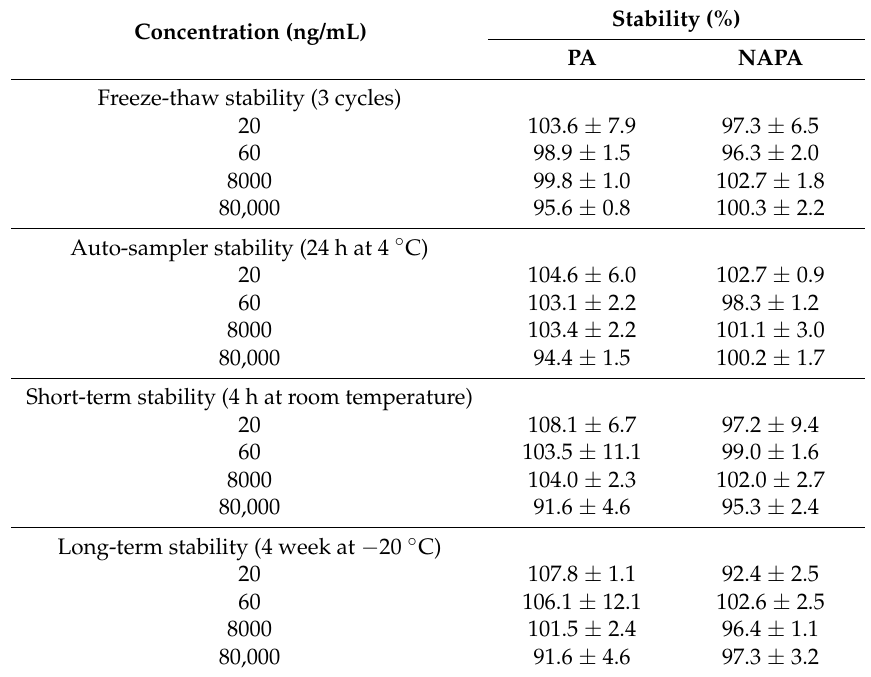
Table 2. Stability of procainamide and N -acetylprocainamide in plasma 1 . Concentration